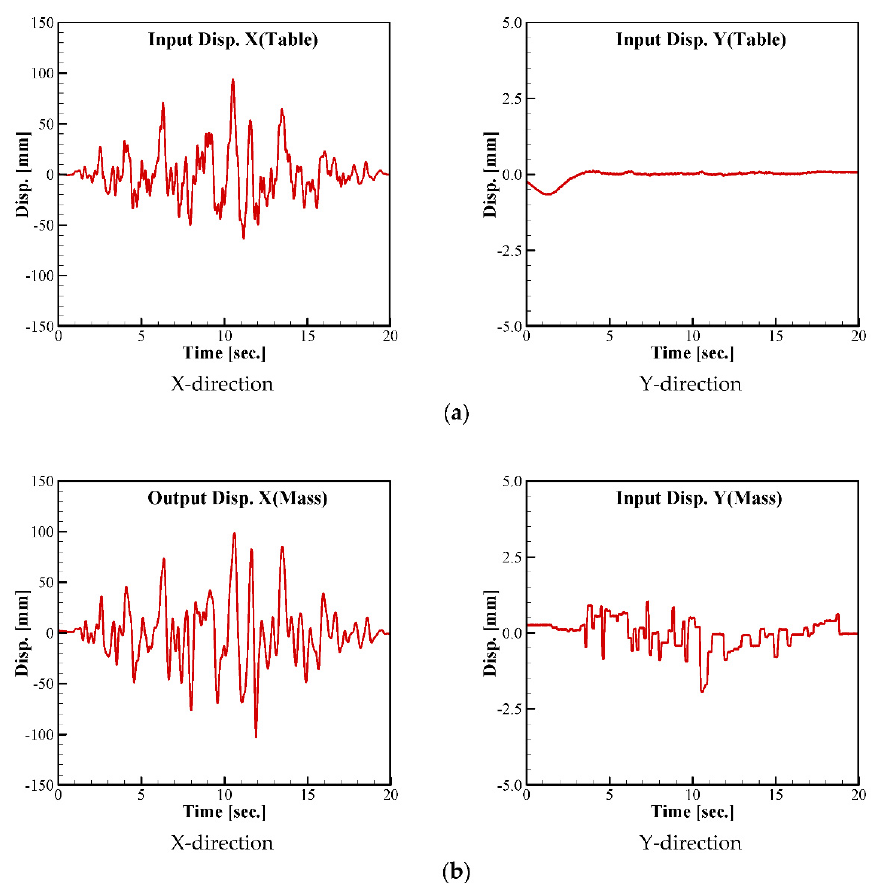
Figure 11. Correlated responses of the damaged LRB in the SSE 1-D Test: ( a ) displacements of the LRB without damage; ( b ) displacements of the LRB with damage.